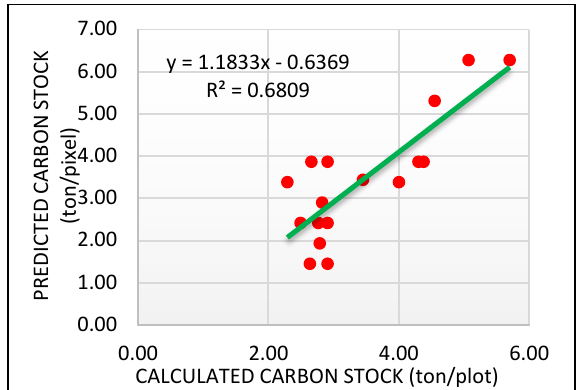
Figure 5. Aboveground Biomass Map of Falcata Plantations in Butuan City .